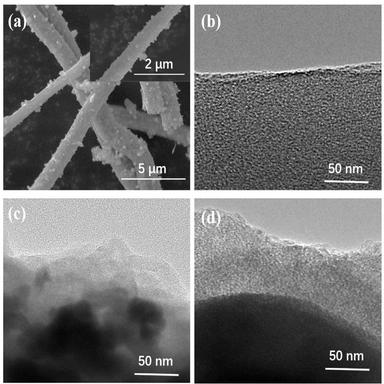
SEM image of SnSb@CMF-2@C (a), HRTEM images of CMF (b), SnSb@CMF-2 (c) and SnSb@CMF-2@C (d).